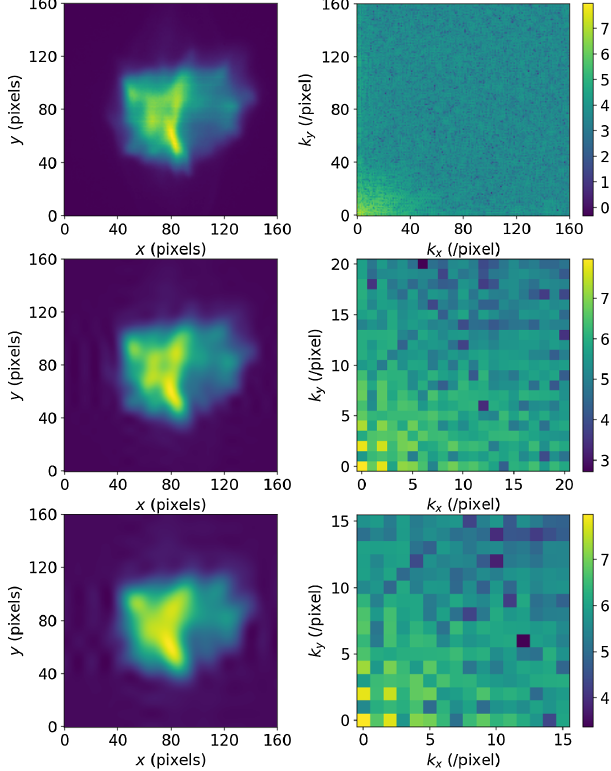
FIG. 6. Image compression using truncation of the DCT. In each pair, the left-hand image shows the beam image in coordinate space reconstructed from the DCT shown in the right- hand image. Images are reconstructed at the resolution of the original image by padding the truncated DCT with zeros as necessary. Top: full resolution, 161 × 161 pixels. Middle: DCT truncated to 21 × 21 . Bottom: DCT truncated to 16 × 16 . Beam images are from a quadrupole scan with 100-pC bunch charge. The color scale shows the logarithm (to base 10) of the absolute value of the DCT